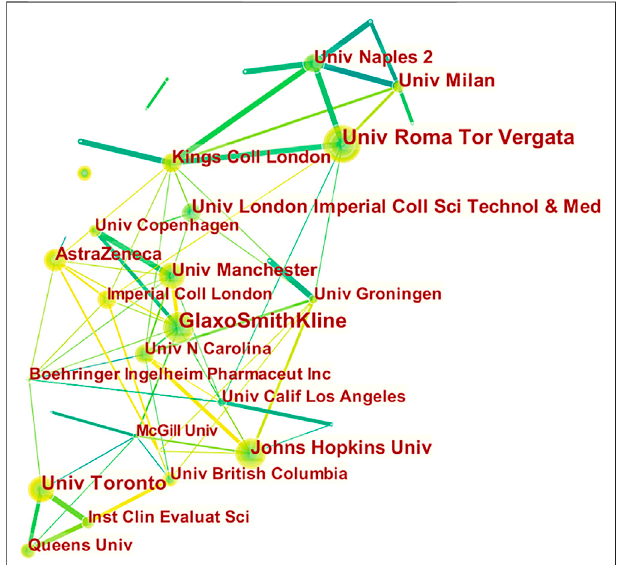
FIGURE 5 | Cooperation among institutions that published COPD drugs-related studies from 1980 to 2021.